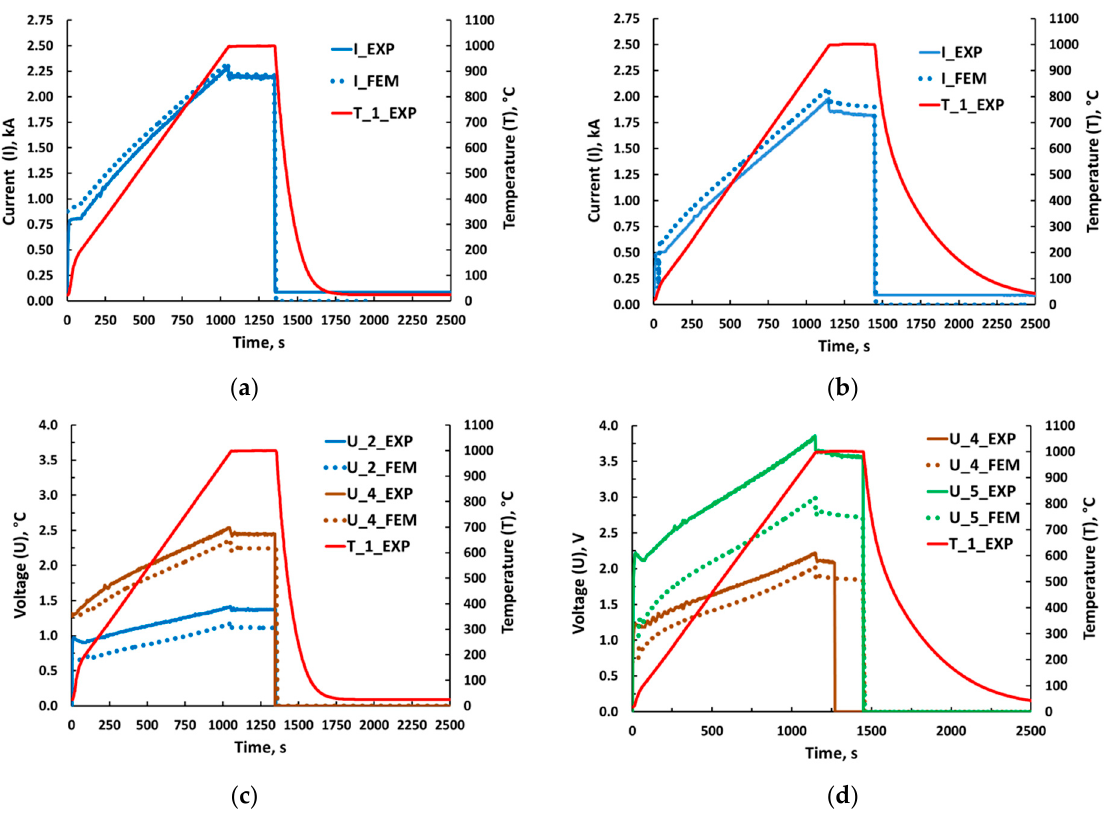
Figure 8. Current ( a,b ) and voltage ( c,d ) development during SPS cycle. Left—regular setup, right—setup with CFRC plates. Solid lines are experimental data and dotted lines are results of FEM modeling. Voltage drop was measured between two symmetric locations in setup.